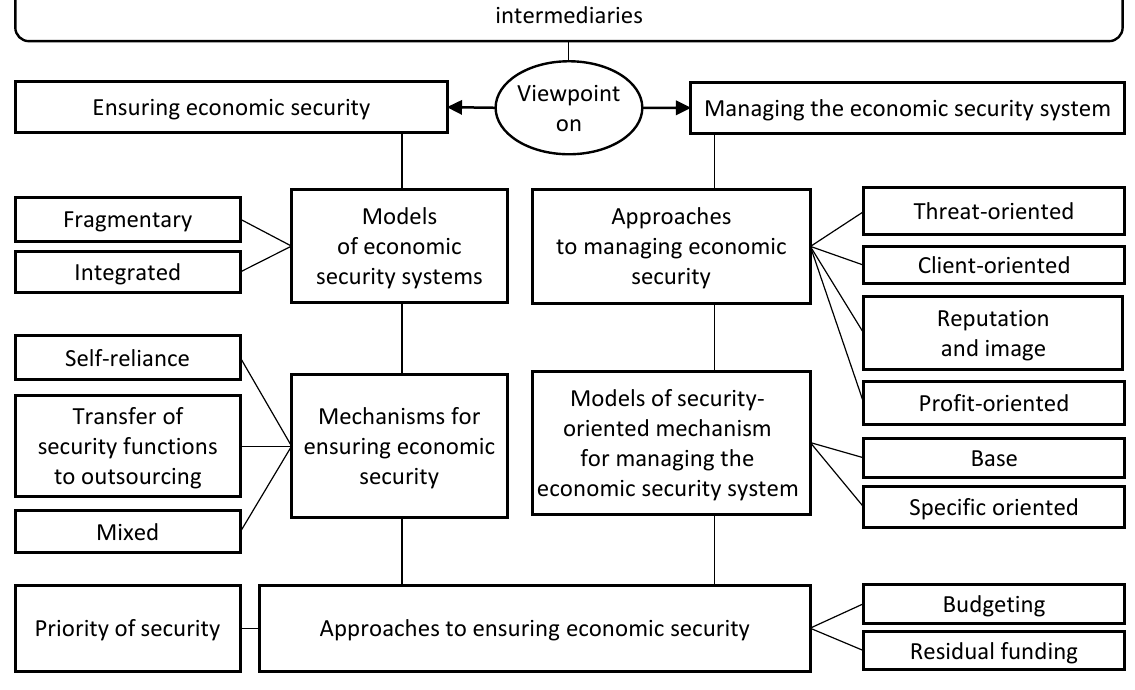
Figure 2. Research and methodological framework for